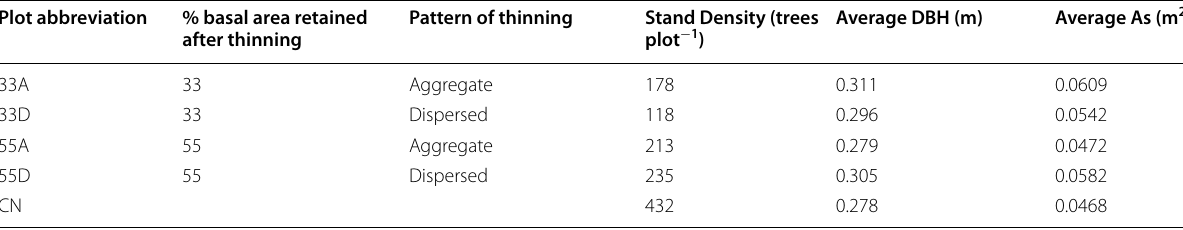
Table 1 Variable Retention Harvesting treatments in TP31 Plot